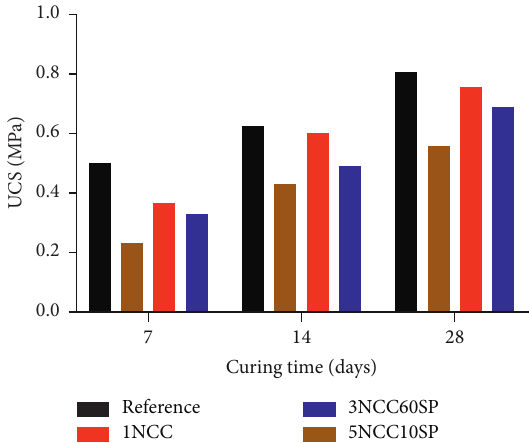
Figure 6: Maximum unconfined compressive strength (UCS) for backfill samples prepared with 0 (reference), 1, 3, and 5% nano-calcium carbonate (NCC) and 0, 10, and 60% superplasticizer (SP). See Table 5, for mixture designs.